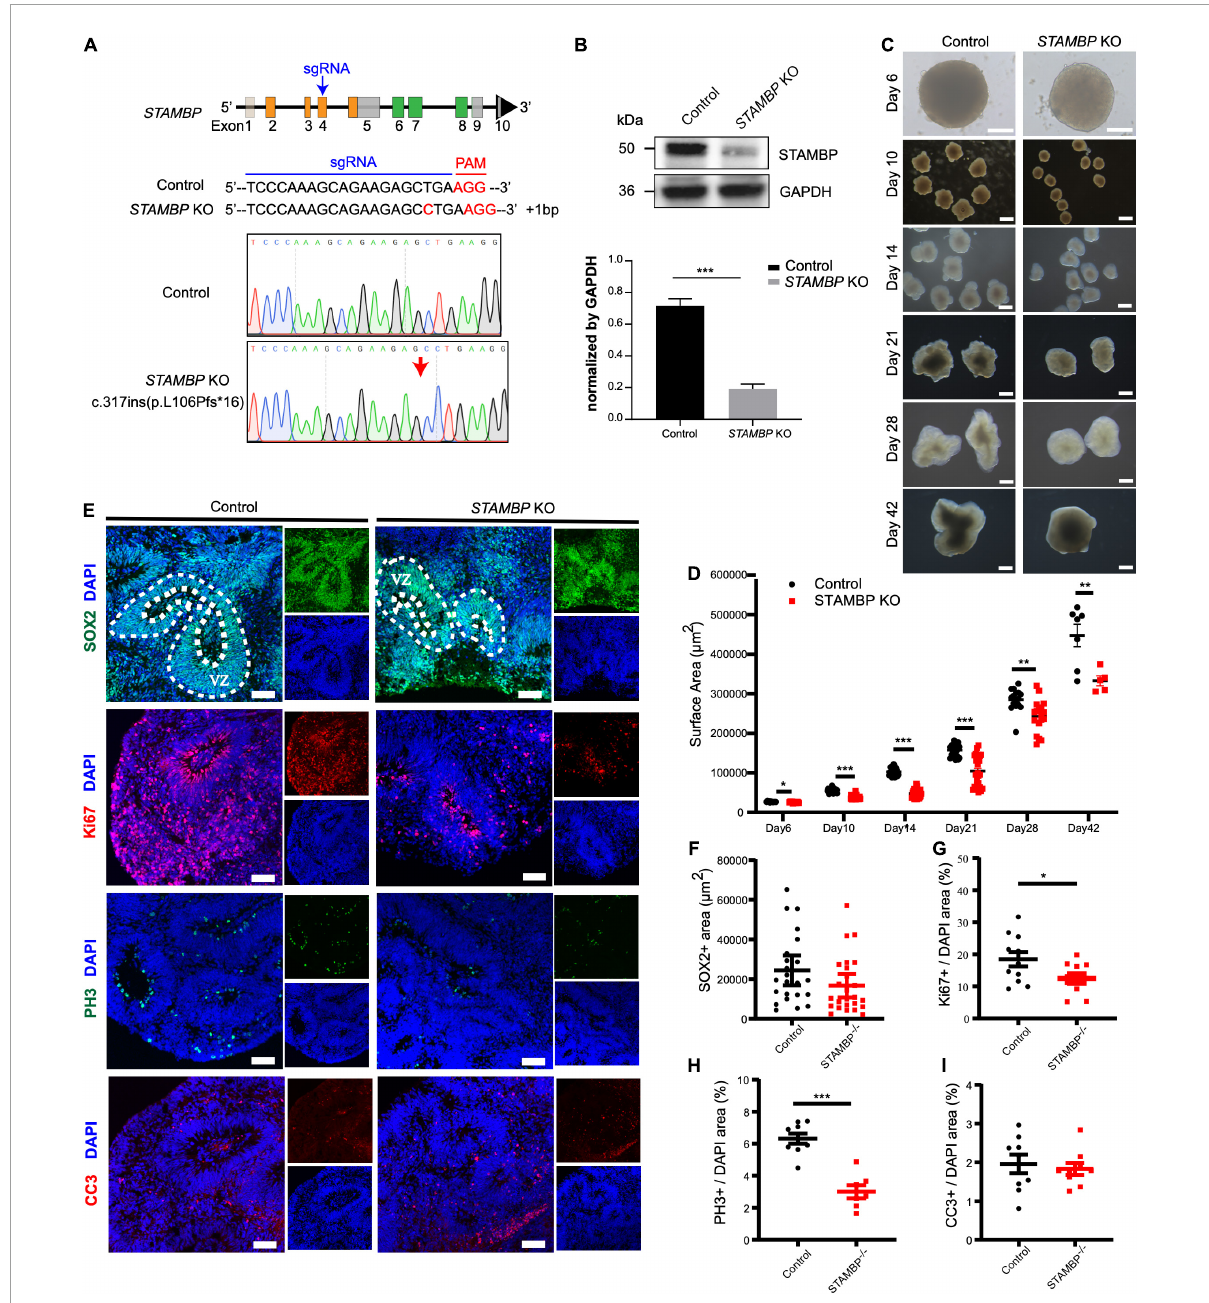
FIGURE4 STAMBP deletion results in smaller cortical organoids sizes and impairs NSC proliferation. (A) CRISPR/Cas9-mediated gene editing of human STAMBP locus in hESCs resulted in a 1 bp insertion in exon 4. (B) Western blot showed ablation of STAMBP proteins due to premature mature stop codons in STAMBP KO hESCs. (C) Representative images of control and STAMBP KO cortical organoids at different differential stages. Scale bars, 200 µ m. (D) Quantification of surface areas of cortical organoids in different developmental stages. Each plot represented an individual organoid. Experiments were repeated three times. Data of day 6, day 21, day 28, and day 42 organoids are presented as mean ± SEM with student’s t -tests. Data of day 10 and day 14 organoids are presented as a median ± 95% confidence interval with the Mann–Whitney test. * p < 0.05, ** p < 0.01, *** p < 0.001. (E) Immunofluorescent staining was performed on sections of control and STAMBP KO cortical organoids on day 28. Sections were stained with SOX2 and DAPI (the first row), Ki67 and DAPI (the second row), PH3 and DAPI (the third row), and CC3 and DAPI (the fourth row). Scale bar: 100 µ m. (F–I) Quantification of the VZ-like SOX2 + rosette area (F) , the ratio of Ki67 + vs. DAPI (G) , the ratio of PH3 + vs. DAPI (H) , and the ratio of CC3 + vs. DAPI (I) . Experiments were repeated three times. Data of SOX2 + area are presented as median ± 95% confidence interval with the Mann–Whitney test. Data of Ki67 + /DAPI, PH3 + /DAPI, and CC3 + /DAPI are presented as mean ± SEM with student’s t -tests. * p < 0.05, *** p <